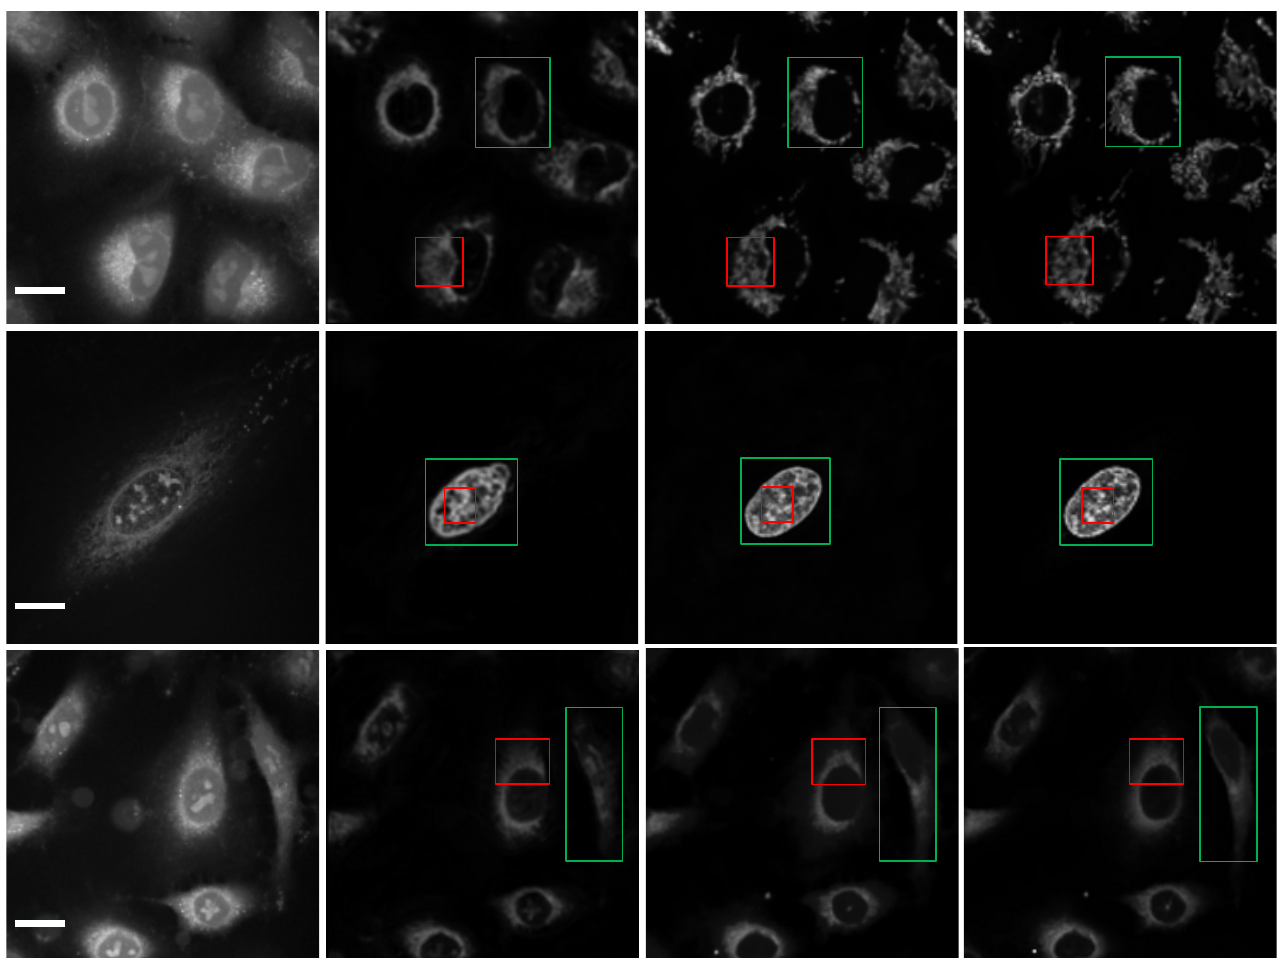
Figure 10. Comparison of the protein subcellular localization results from raw cell images ( first column ) among various prediction algorithms, including Unet ( second column ), UwUnet ( third column ), and MPFnent ( fourth column ). Local feature regions (red box), global representa- tions (green box). Scale bar, 25 µ